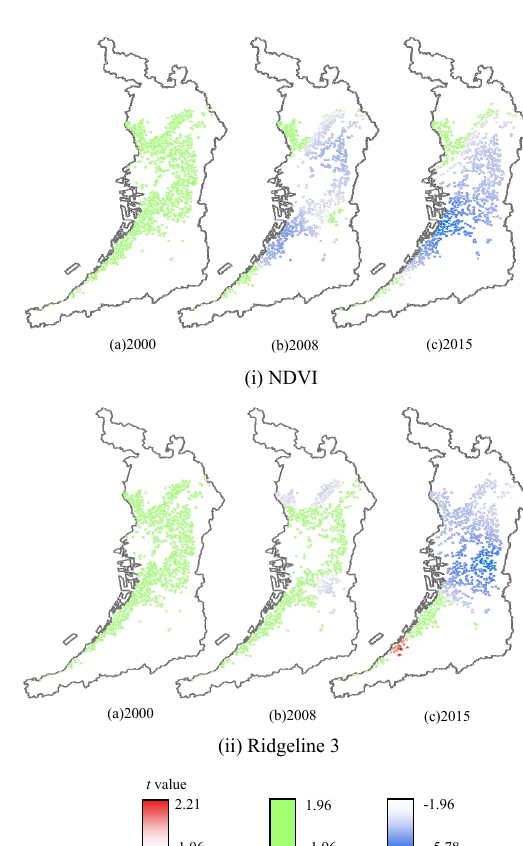
Figure 5. Spatial distribution of t values in